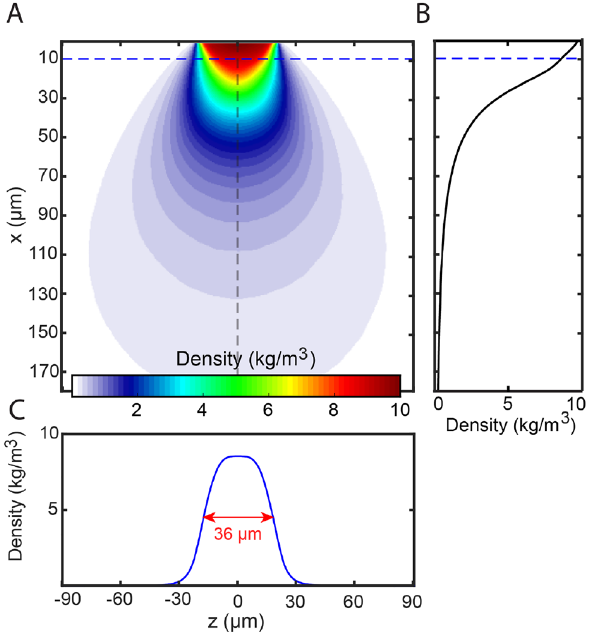
Figure 4: High-order harmonic generation (HHG) gas target simulations for argon as generation gas. (A) Simulated gas density (12 bar backing pressure) in the interaction region with a 42 μ m nozzle centered around z = 0. (B) Densityat z =0(black).(C)Lineoutofthegasdensityatadistanceof 10 μ mfrom the nozzle.InA andB, thedashed blueline indicatesthe position of the line-out in C. In A, the dashed gray line indicates the position of the line-out in